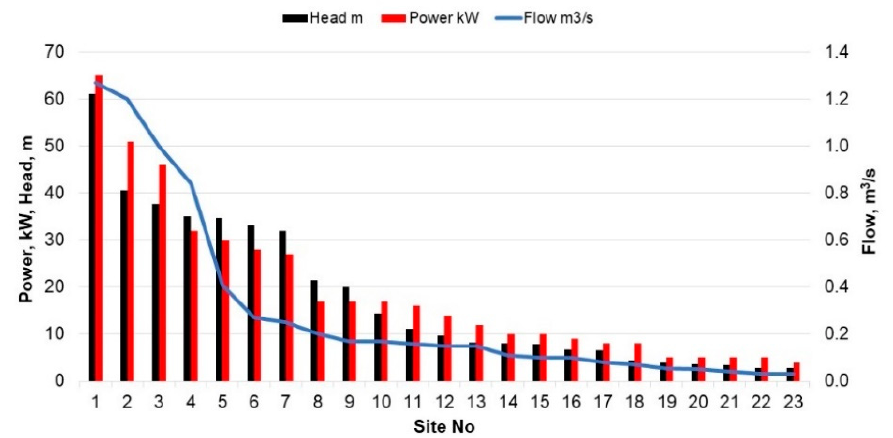
Figure 2. Key data of potential sites in urban water network (mostly wastewater) for installing hydro turbines.